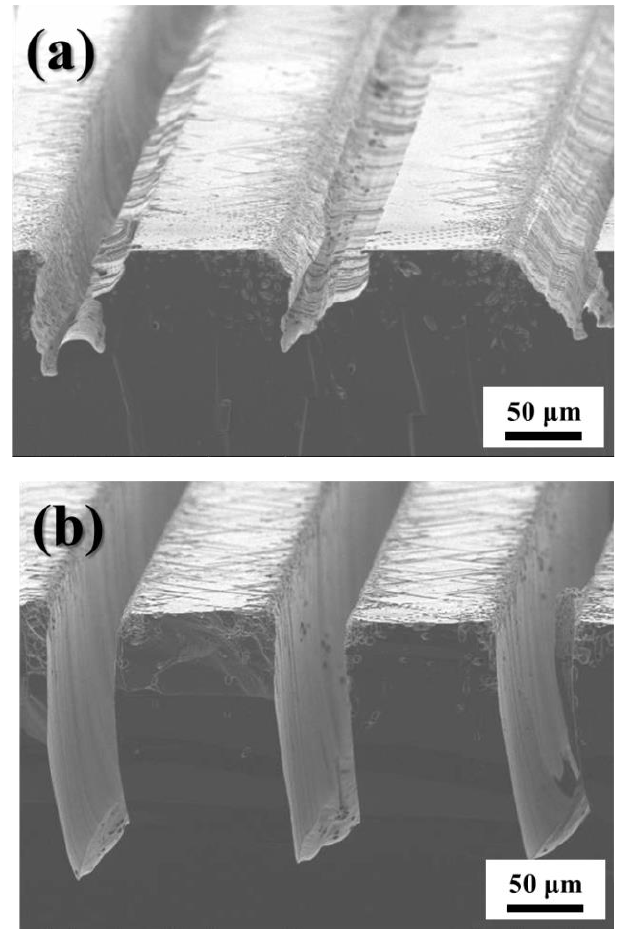
Figure 5. Curved Si groove arrays produced by magnetically guided MACE for 5 h using ( a ) a Swiss-cheese-like Au / Fe / Au catalyst and ( b ) Au / Fe encapsulated / Au catalyst (tilting angle: 30°).